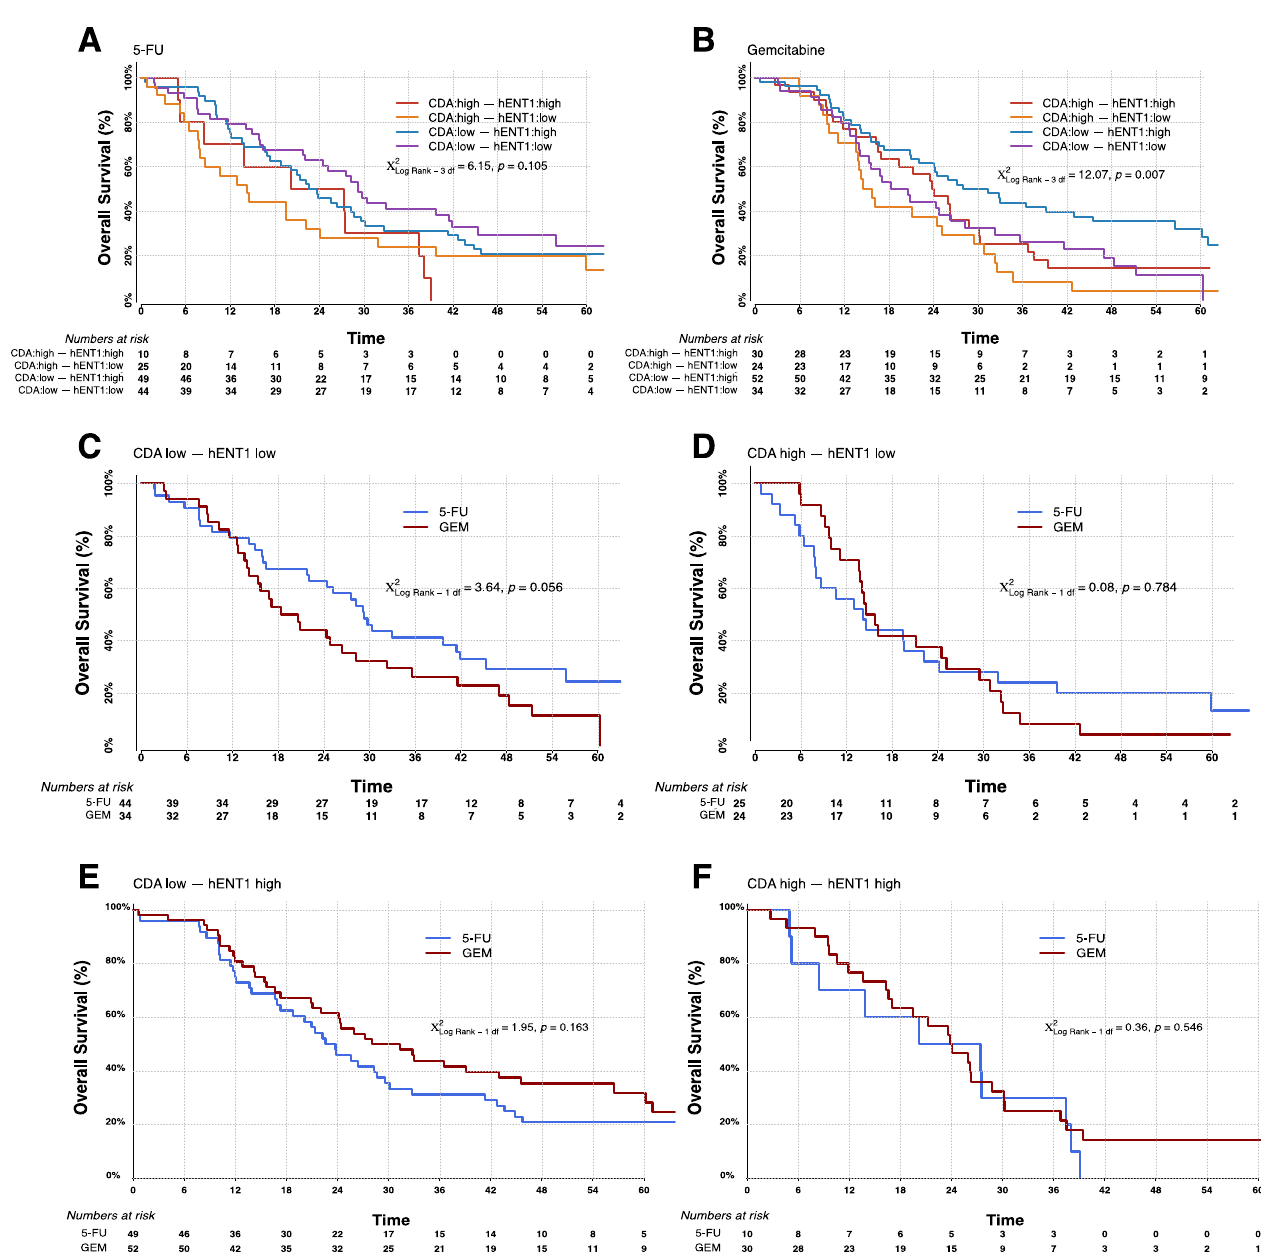
Figure 3. Kaplan-Meier survival curves for analyses of combined CDA mRNA and hENT1 protein biomarker interaction looking at all expression level combinations (CDA low, hENT1 low; CDA high, hENT1 low; CDA low, hENT1 high; CDA high, hENT1 high). Graphs show response to treatment with 5-FU ( A ) and gemcitabine ( B ). In ( C , D ) the same data as above is presented showing the difference in survival for patients treated with 5-FU compared to gemcitabine in patients with low hENT1 protein and either low CDA ( C ) or high CDA ( D ), and patients with high hENT1 protein and either low CDA ( E ) or high CDA ( F ). All groups and the number of at-risk individuals are shown for each graph. All p -values were determined by log-rank analyses using two-sided χ 2 tests.